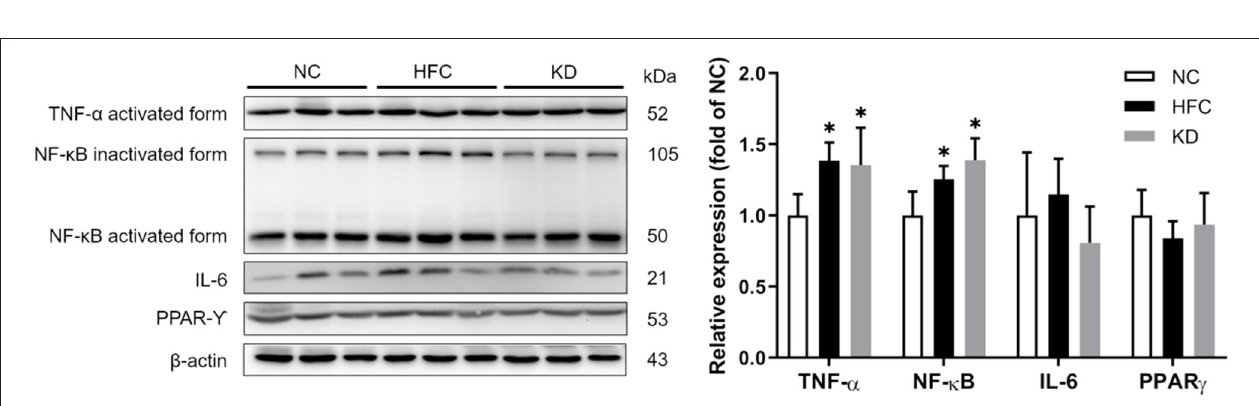
FIGURE 8 | Effects of a high-fat and high-cholesterol diet and a ketogenic diet on testicular inflammation pathway regulators (TNF- α , NF κ B, IL6, and PPAR g ) in male mice. Protein expressions in each group were measured using western blot analysis, and β -actin was used for normalization. * p < 0.05, compared with the NC group; # p < 0.05, compared with the HFC group. NC, normal diet; HFC, high-fat and high-cholesterol diet; KD, HFC diet changed to MCT-based ketogenic diet.